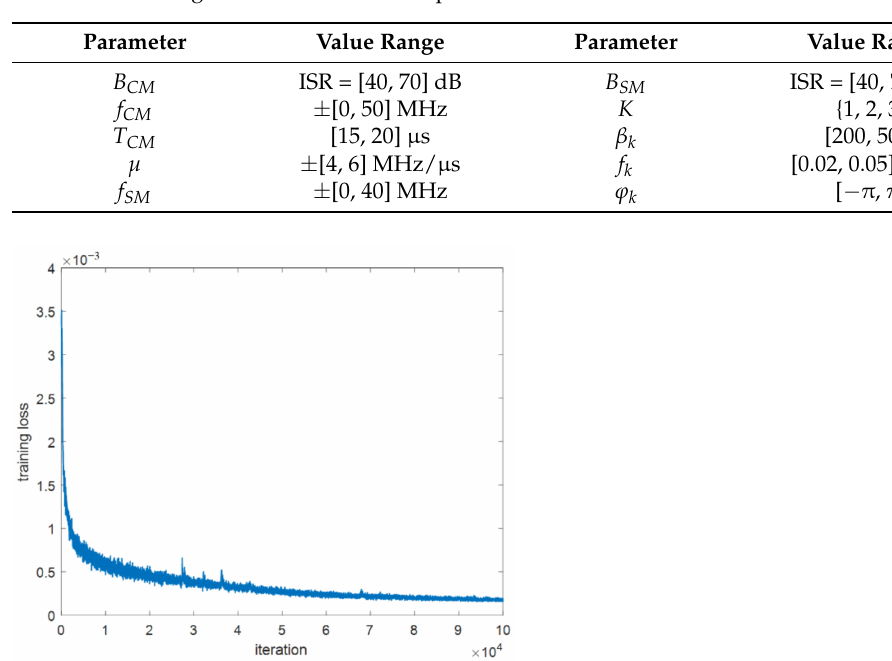
Table 1. Value range of the simulated WBI parameters.